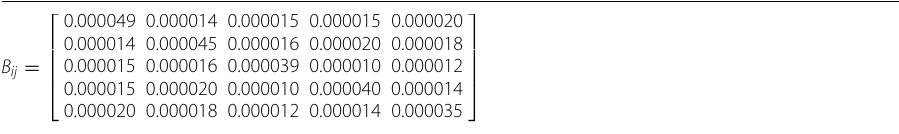
Table 3 B -matrix coefficients (per MW) [31]